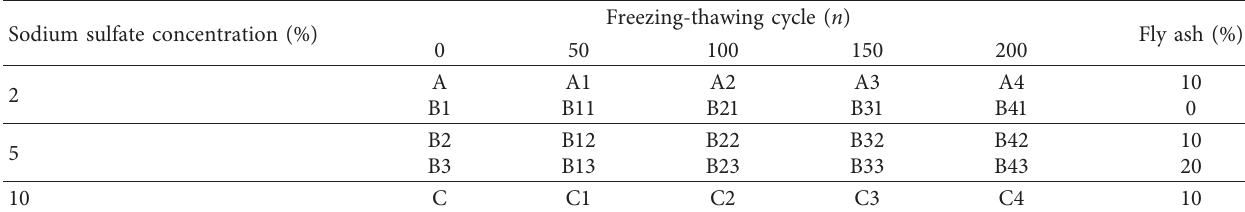
Figure 1: Temperature-time curve during the freeze-thaw cycle. Table 4: Experimental